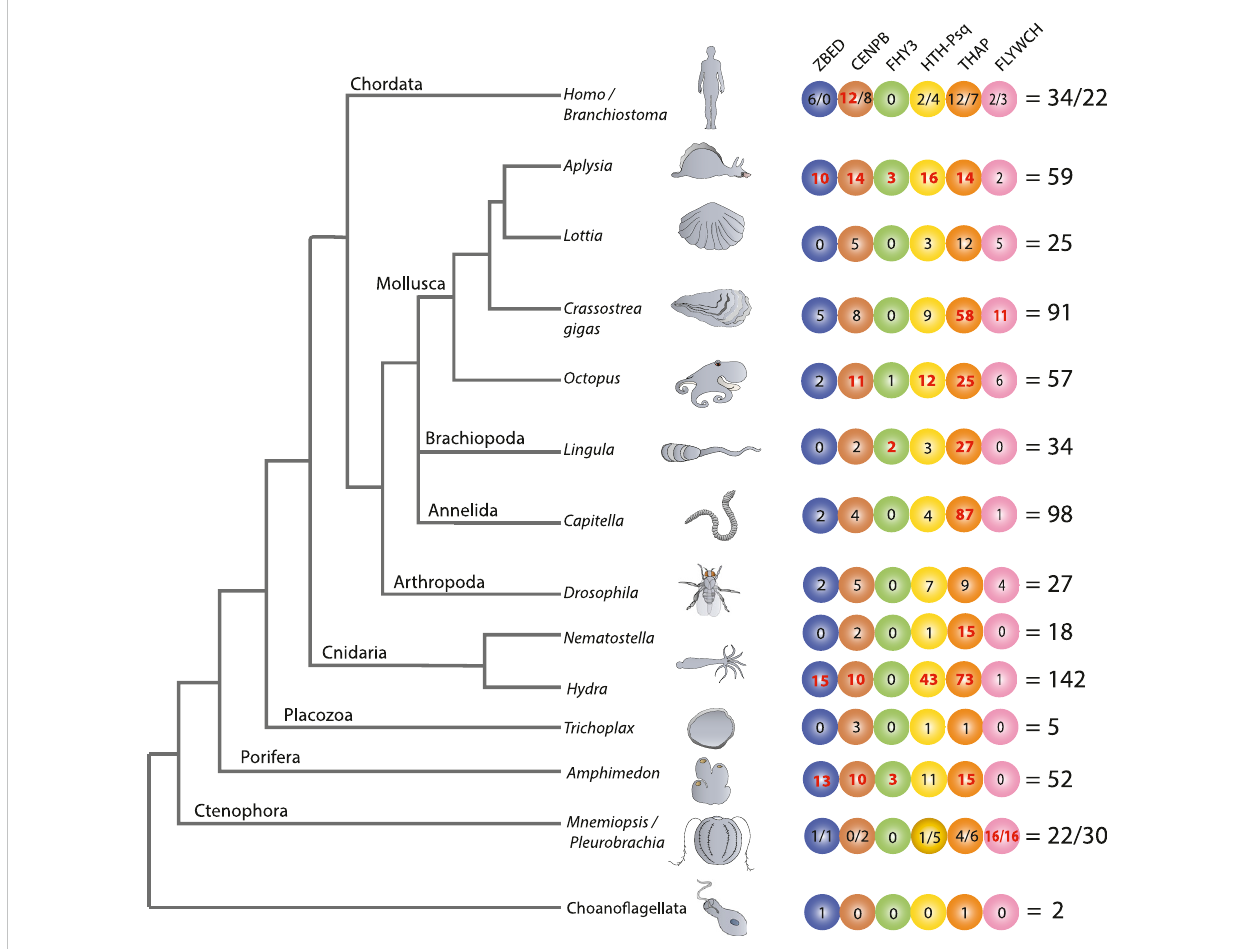
FIGURE 1 Transposon-derived transcription factors across metazoans. The diagram shows lineage-speci fi c expansion and mosaic distributions of six families oftransposon-derivedtranscription factors (TFs)acrossmetazoans.All TFsdepicted inthetree arelineage-speci fi cgenesthat have nohomologinother classesorphyla.EachcoloredcirclerepresentsoneofthesixpotentiallyTE-derivedTFgenefamilies:ZBED,CNPB,FHY3,HTH-Psq,THAP,andFLYWCH. Figures within circles indicate several independent species-speci fi c events of the domestication of a particular TF family. The total numbers of transposon-derived TFs identi fi ed in each reference species are shown on the right. We observed the most extensive expansion of transposon-derived TFs in four bilaterian lineages led to the hydrozoan polyp — Hydra (142), the oligochaete — Capitella (98), the sea slug — Aplysia (59), and the bivalve — Crassostrea (91). Of note, a signi fi cant expansion of the THAP gene family occurred in Capitella (87), Hydra (73), and Crassostrea (58). Independentspecies-speci fi cexpansions oftheFLYWCHgenefamily occurred inctenophores Mnemiopsis (16) and Pleurobrachia (16).The “ / ” symbolis usedtodifferentiatethenumbersidenti fi edunderbothspecies,suchasin Homo / Branchostoma and Mnemiopsis / Pleurobrachia, etc.,Theboldredletter indicates when the values are signi fi cantly higher in numbers compared to other